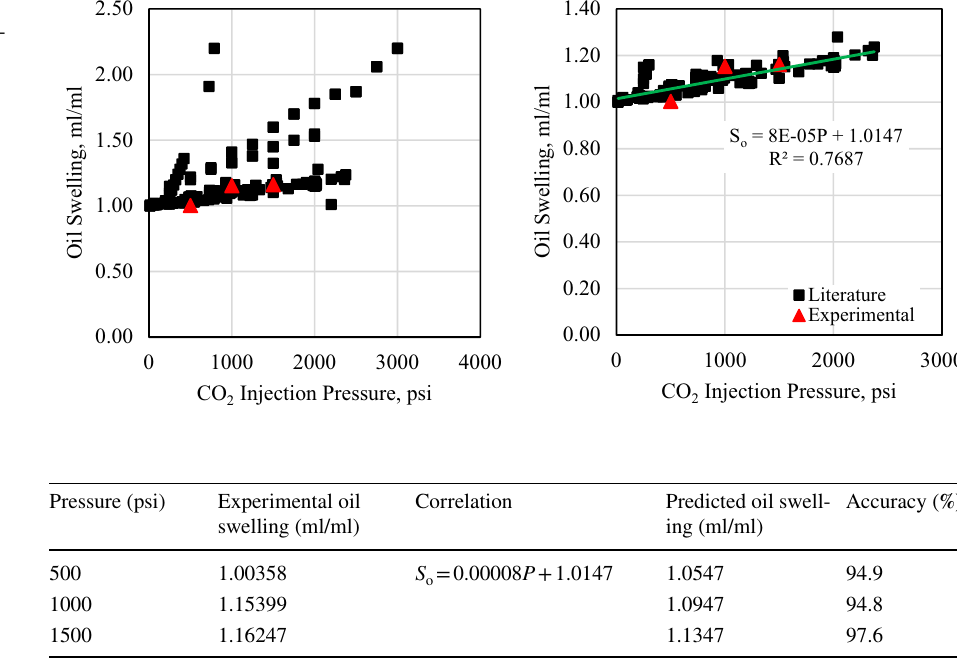
Fig. 6 Experimental and litera- ture oil swelling values at differ- ent CO 2 injection pressures